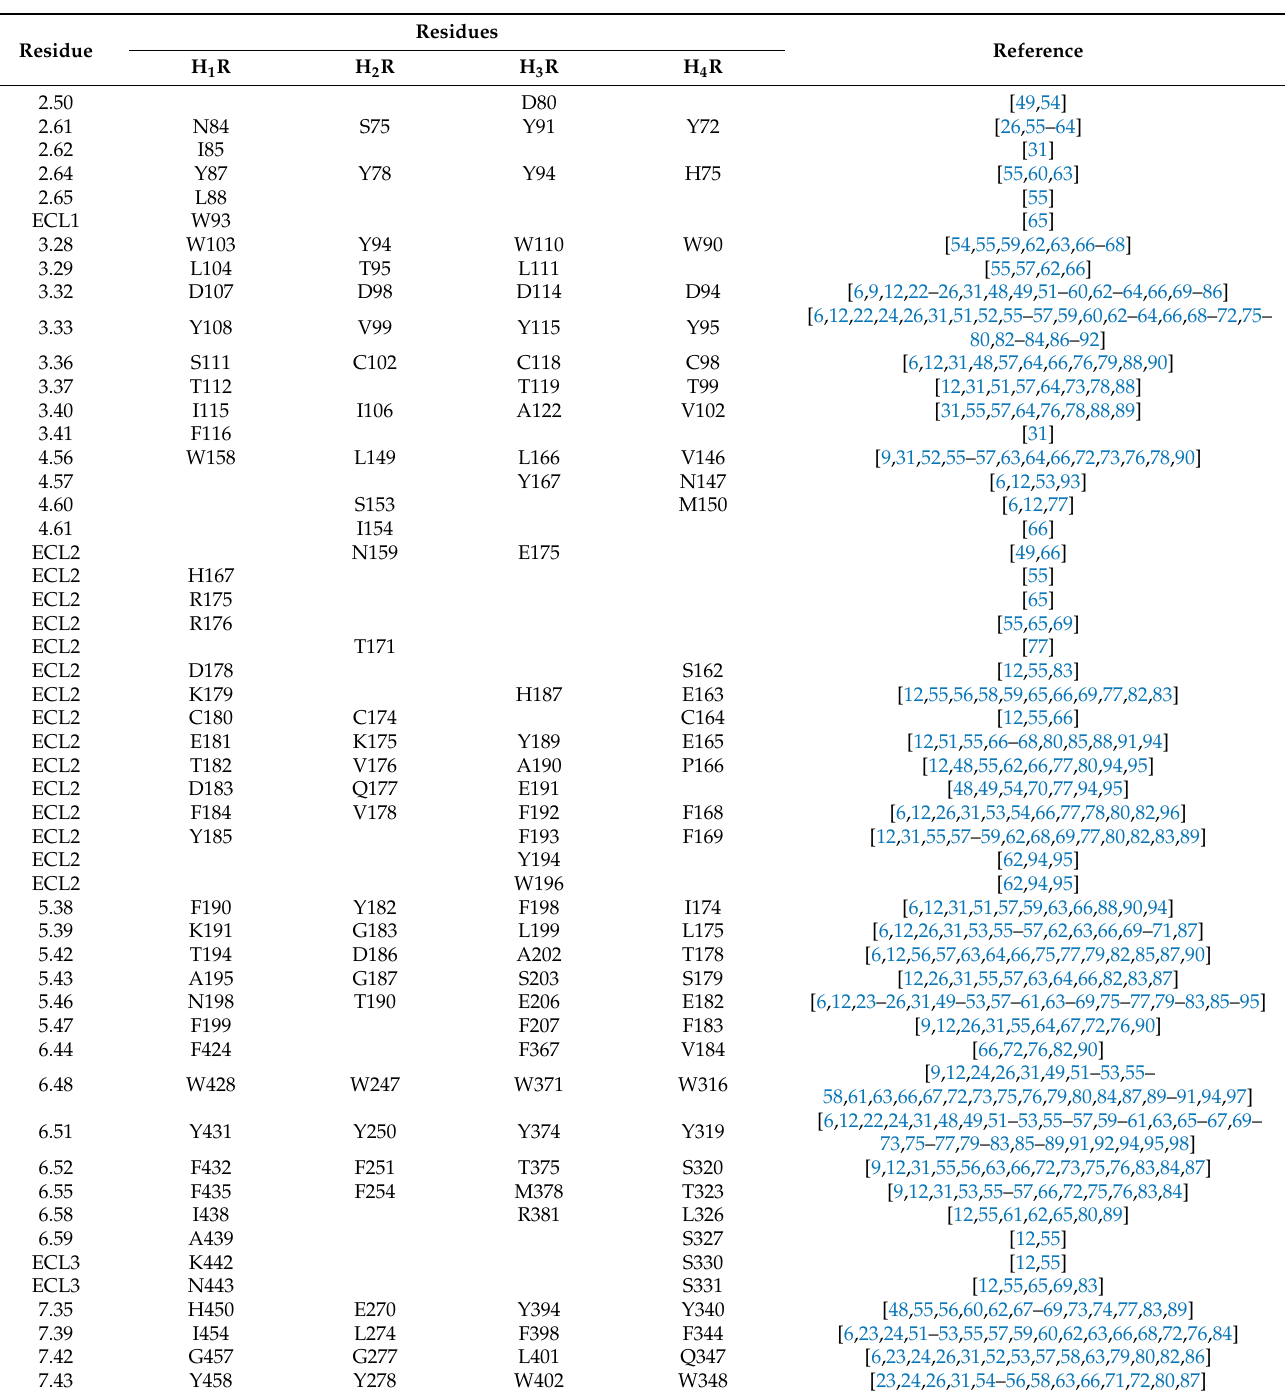
Table 2. Residues (in B-W numbering scheme) of HR subtypes involved in the binding of ligands studied in particular